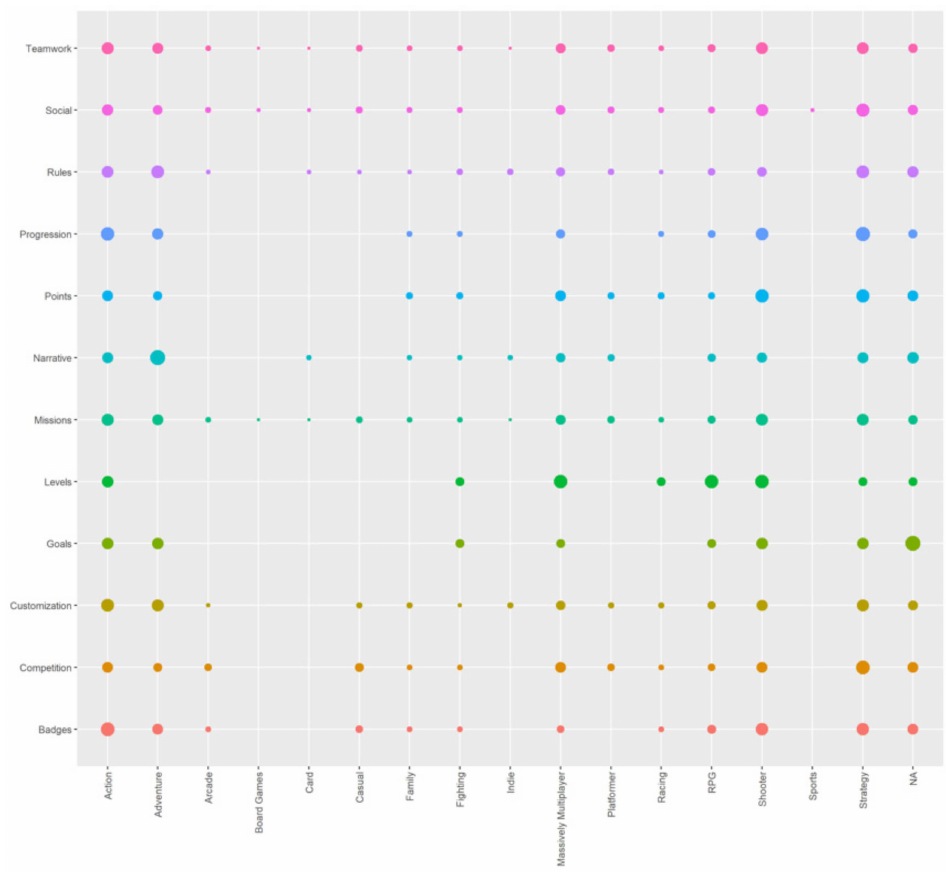
Figure 20. Points graph showing the percentage of appearance of each game genre in each type of gamification element by the size of the point, the color indicates the game